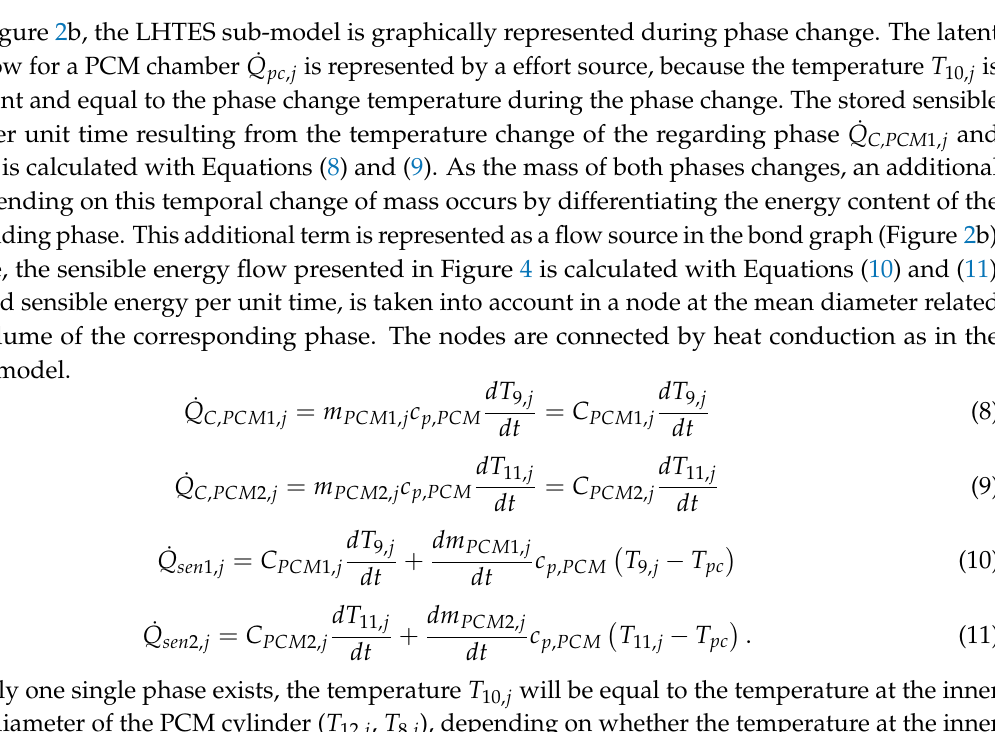
Figure 4. Sub-model: latent thermal energy storage